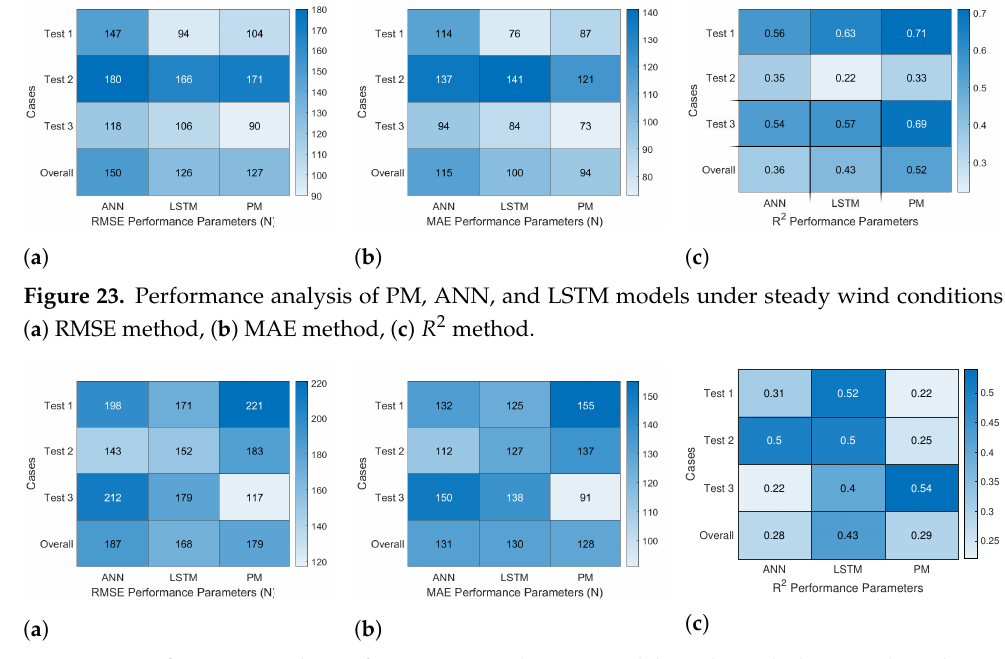
Figure 24. Performance analysis of PM, ANN, and LSTM models under turbulent wind conditions: ( a ) RMSE method, ( b ) MAE method, ( c ) R 2